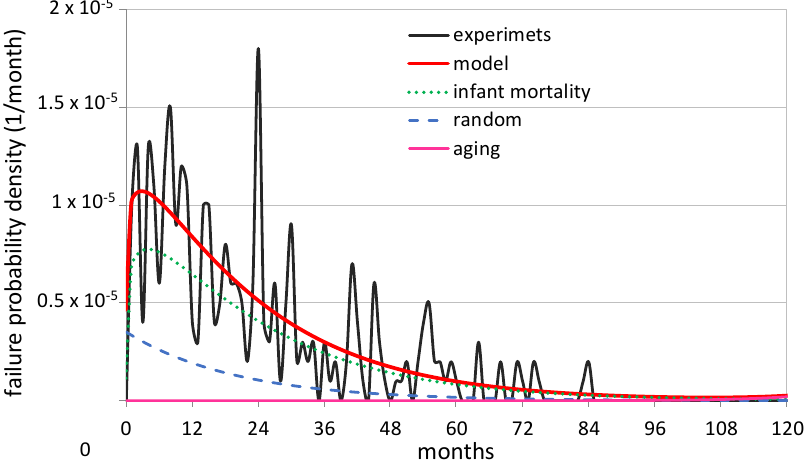
Figure 7. Failure probability density function of integrated circuits: experimental data, model and single components of the model.